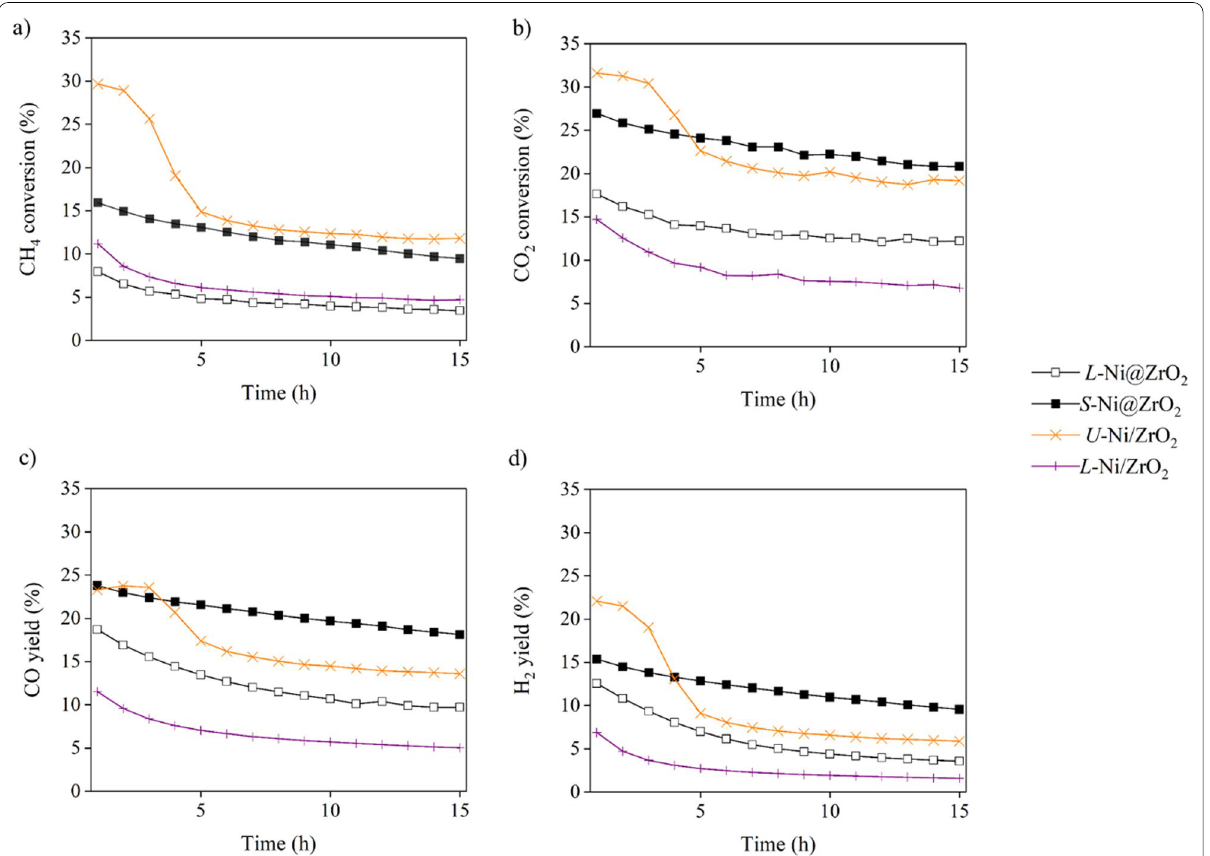
Fig. 5 CH 4 and CO 2 conversions; CO and H 2 yields of DRM reactions catalyzed by U -Ni/ZrO 2 , L -Ni/ZrO 2 , L -Ni@ZrO 2 , and S -Ni@Y 2 O 3 -ZrO